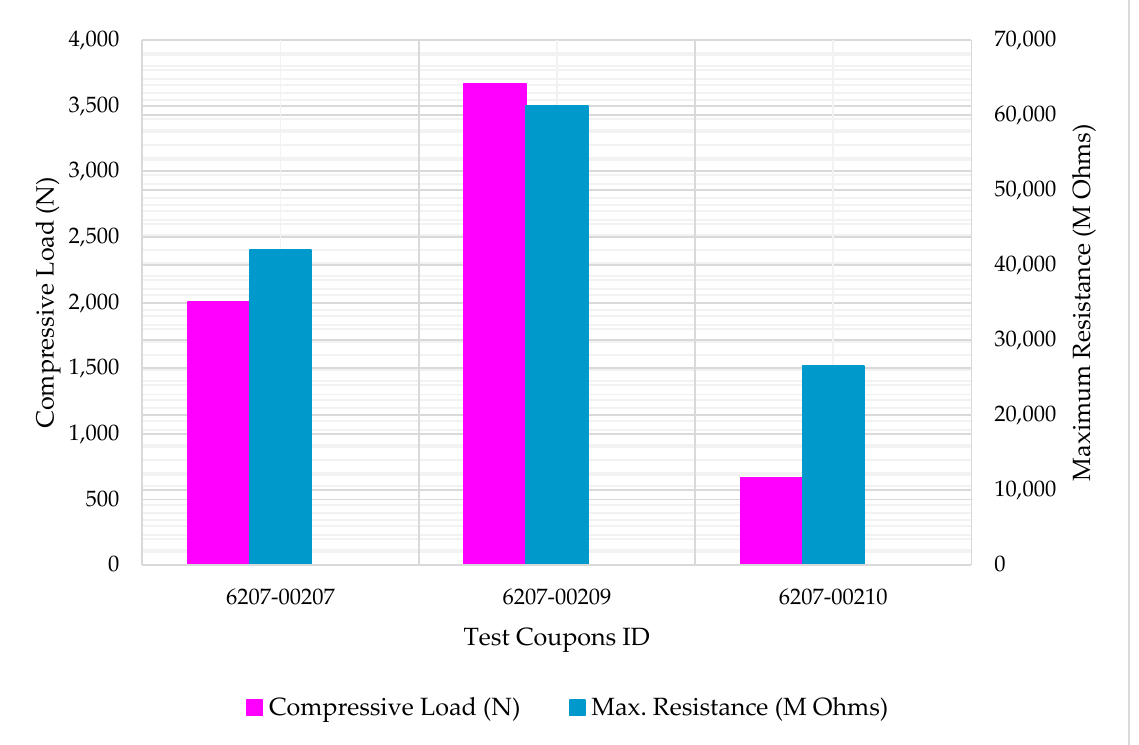
Figure 11. Multifunctional Compressive ‐ Electrical behavior of test coupons (6207 ‐ 00207, 6207 ‐ 00209, and 6207 ‐ 00210) at RTD.